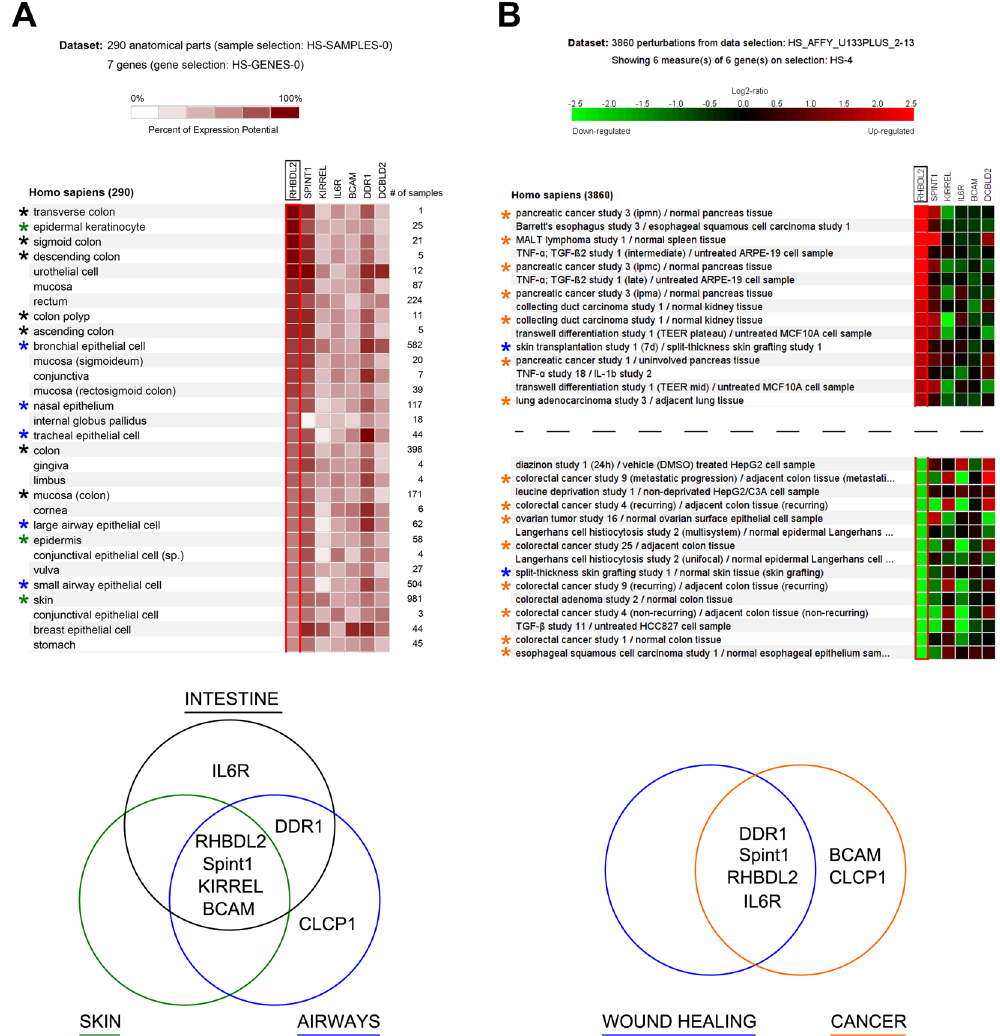
Figure 5. Overlapping functions and expression of novel RHBDL2 substrates. Gene expression was analysed using the Genevestigator environment 20 . See main text for further details. ( A ) Co-expression of RHBDL2 and its substrates. Tissues were ranked from high to low according to the relative expression level of RHBDL2 and the top 30 results are displayed. The relative expression level of novel substrates was also analysed in these tissues and functionally linked tissues are highlighted with colour-coded asterisks and summarised in the Venn diagram which shows particularly high levels of expression of RHBDL2 and its substrates occurs in distinct tissues. ( B ) Potential biological roles for RHBDL2 and its substrates. Studies were ranked according to conditions in which RHBDL2 is both most upregulated and downregulated and the top 15 results in each case are displayed. Regulation of novel RHBDL2 substrates is presented alongside. Recurring conditions are highlighted with colour-coded asterisks and summarised in the Venn diagram which shows changes in gene expression of RHBDL2 and its substrates occurs in distinct biological